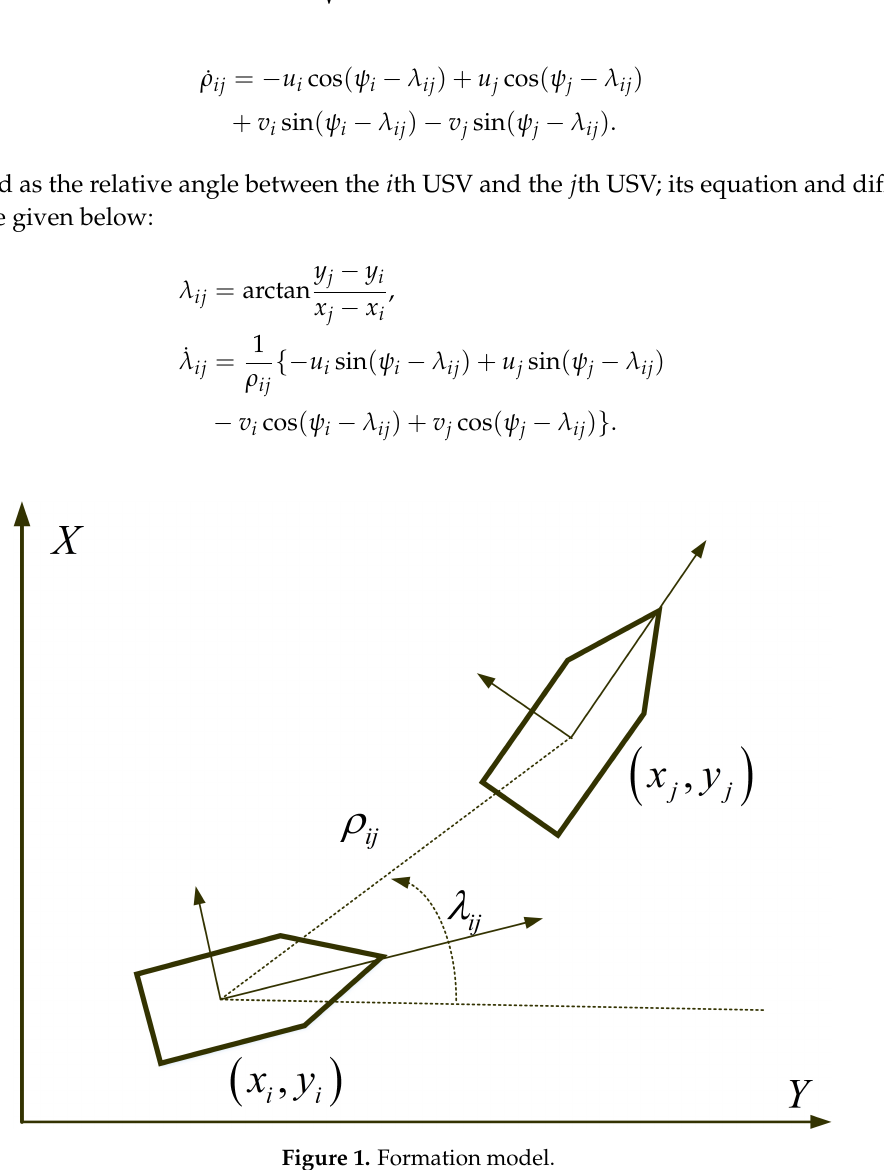
Figure 1. Formation